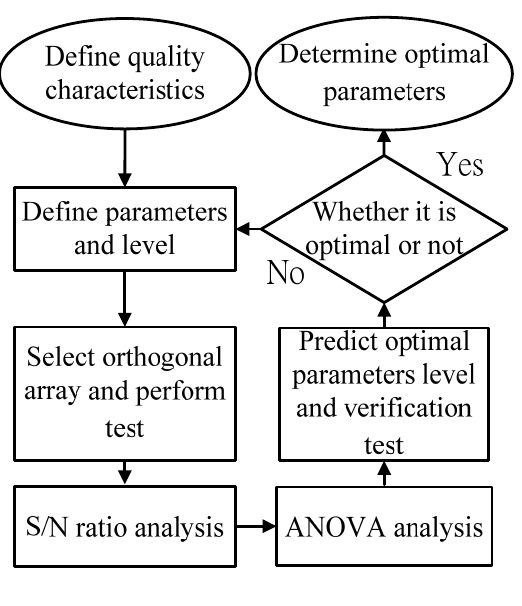
Figure 2. Taguchi method flow.